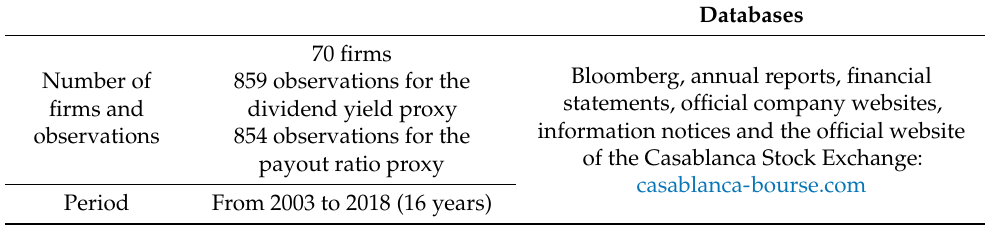
Table 1. Sample and databases.